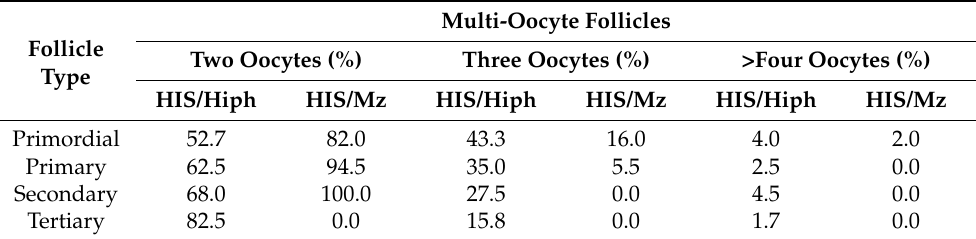
Table 2. The number of oocytes observed in the multi-oocyte follicles of each follicular developmental stage in the ovaries of HIS/Hiph and